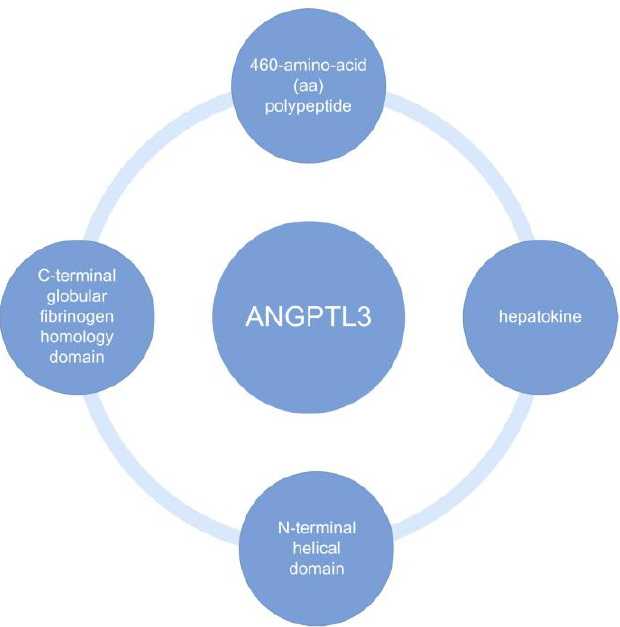
Figure 1. Biochemical Structure of ANGPTL3 [21,22]. ANGPTL3, angiopoietin-like protein